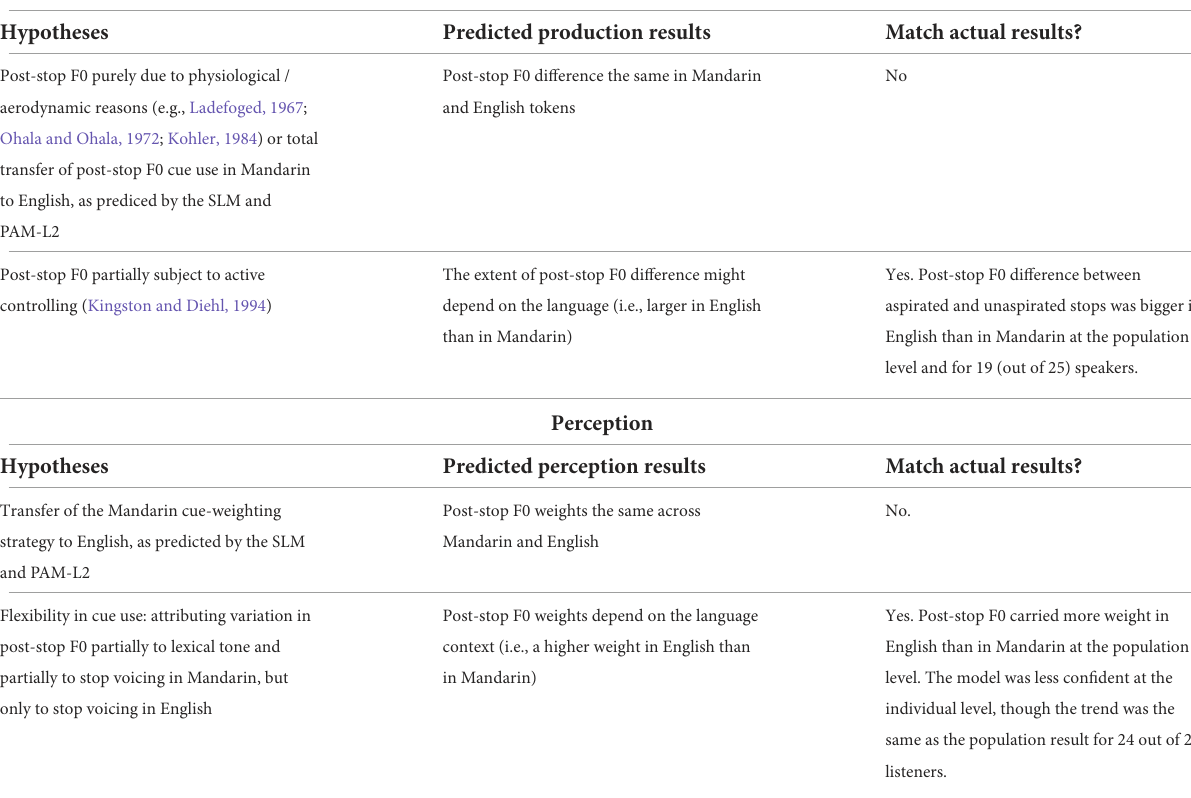
TABLE 6 Predicted and actual production and perception results under difference